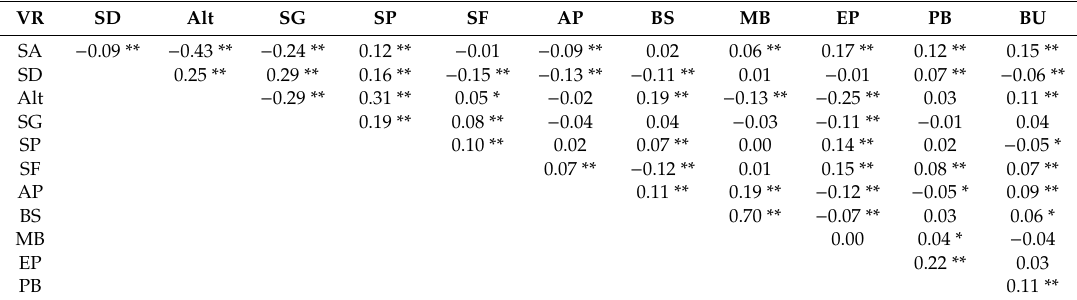
Table A2. Partial correlation matrix among tree quality, stand characteristics, and site characteristics. Variables (VR). Stand age (SA). Stand density (SD). Altitude (Alt). Slope gradient (SG). Slope position (SP). Stem form (SF). Axis persistence (AP). Branch sizes (BS). Mode of branching (MB). Epicormic shoots (EP). Protuberant buds (PB). Buttressing (BU).